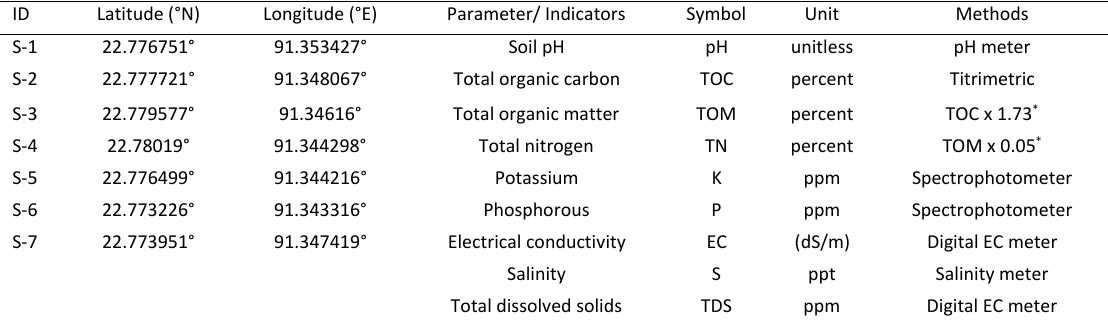
Table 1. Geographical position of sample sites and methods of parameter/indicators for experiments ID